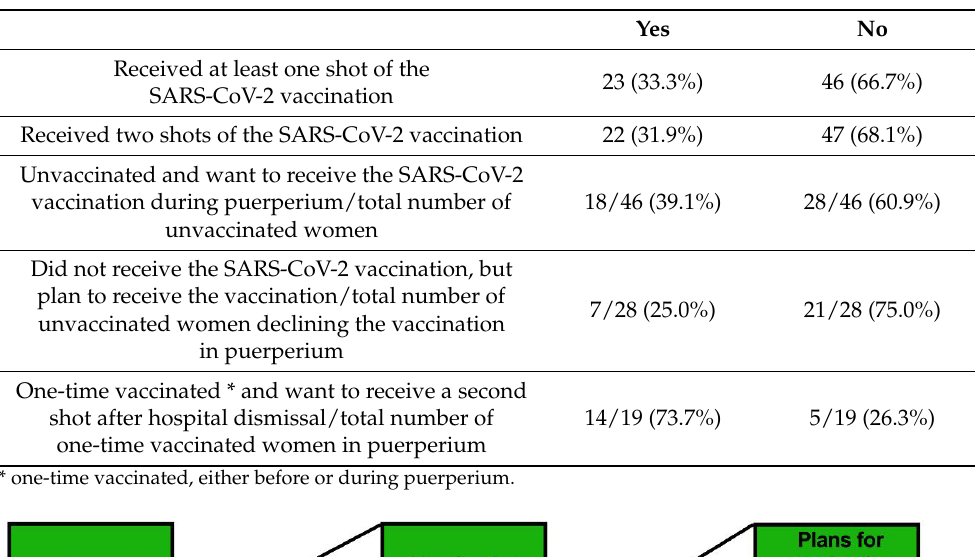
Table 2. Assessment of SARS-CoV-2 vaccination status and willingness to receive the vaccination among 69 women in the evaluation group.